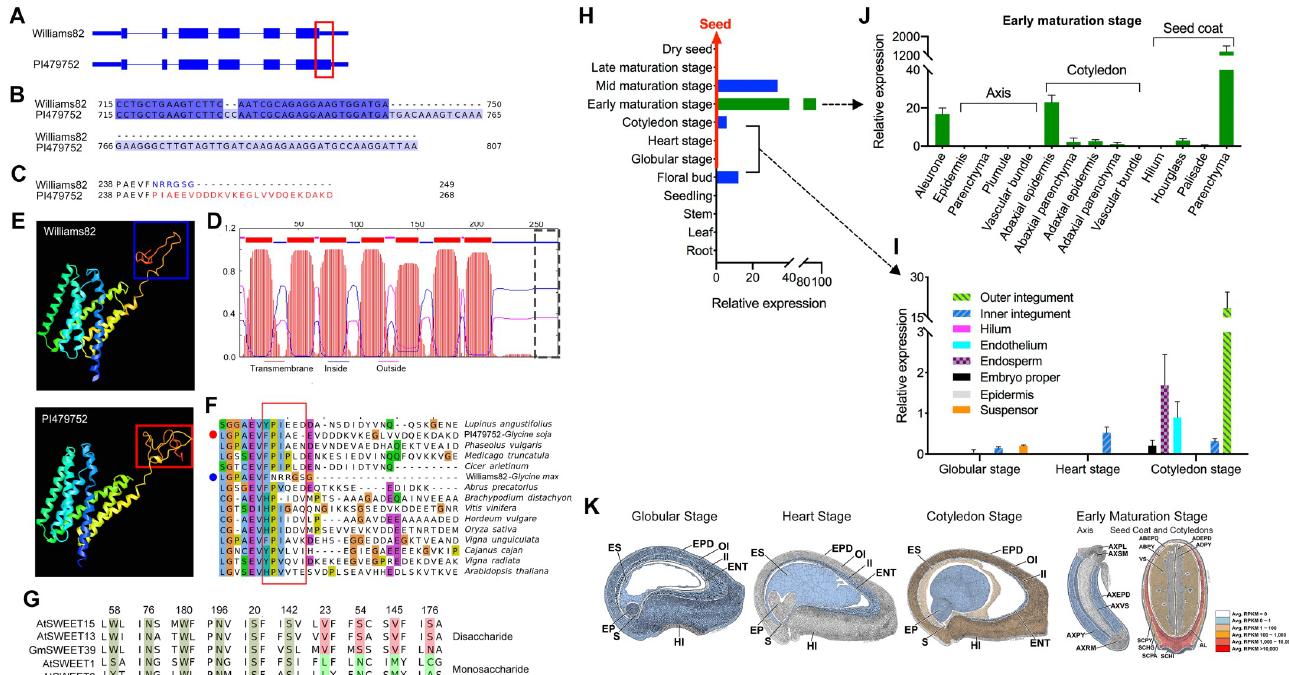
Fig 2. Sequence and expression analysis of GmSWEET39 alleles. ( A ) A schematic diagram shows the sequence variation that occurs in the 6th exon between the two parental lines of the RIL population, Willams82 and PI479752. ( B ) The CC deletion in Williams82 causes a reading frameshift and a truncated protein at the C-terminus. ( C ) GmSWEET39 is 19 amino acid shorter in Williams82 than it in PI479752. ( D ) Predicted transmembrane domains in GmSWEET39. The sequence differences as shown in (B) and (C) were highlighted with the gray dotted rectangle. ( E ) Comparison of the 3D protein structure between Willams82 and PI479752 GmSWEET39 proteins. The difference in the structure at the C-terminal tails is highlighted with rectangles in blue and red. ( F ) Sequence alignment between the C-terminal peptides of the SWEET homologs from different species including legumes. The putatively conserved region was highlighted with the rectangle in red. ( G ) GmSWEET39 is conserved at the amino acids essential for disaccharide transport. ( H ) A bar plot showing the expression pattern of GmSWEET39 in different soybean tissues and the whole seeds at different maturation stages. ( I ) Relative expression of GmSWEET39 in different subregions of developing seeds of soybean cultivar Williams 82 (CC deletion) at globular, heart, and cotyledon stages. ( J ) Relative expression pattern of CC-deleted GmSWEET39 in the sub-regions in developing seeds of Williams 82 at the early maturation stage. ( K ) Cartoon depicting the expression patterns of GmSWEET39 in different tissues/compartments of globular, heart, cotyledon, and early maturation seeds of Williams 82 (CC deletion). Abbreviation: AB—Abaxial; AD— Adaxial; AL—Aleurone; AX—Axis; Cot—Cotyledon; EP—Embryo Proper; EPD—Epidermis; ENT—Endothelium; ES—Endosperm; FBUD—Floral Bud; HG— Hourglass; HI—Hilum; II—Inner Integument; OI—Outer Integument; PA—Palisade; PL—Plumule; PY—Parenchyma; RM—Root Meristem; S—Suspensor; SC —Seed Coat; SM—Shoot Meristem; VS—Vascular Bundle. The seed images were acquired from http://seedgenenetwork.net/sequence.